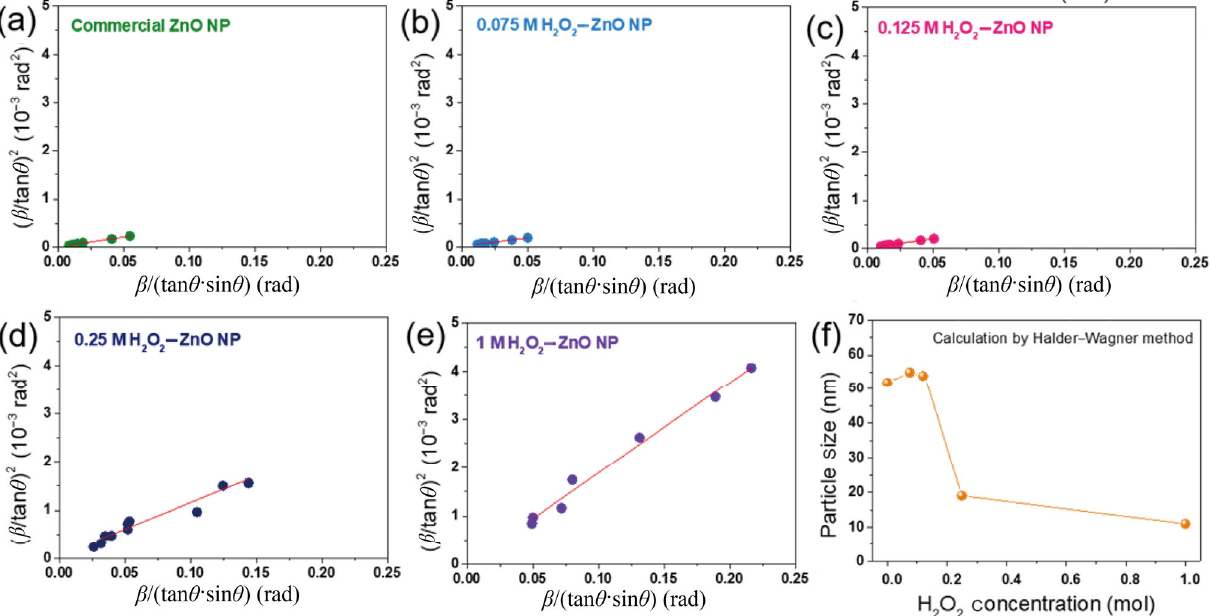
Fig. 3 Halder–Wagner plots of (a) commercial ZnO NPs, (b) 0.075 M H 2 O 2 treated/annealed ZnO NPs, (c) 0.125 M H 2 O 2 treated/annealed ZnO NPs, (d) 0.25 M H 2 O 2 treated/annealed ZnO NPs, and (e) 1 M H 2 O 2 treated/annealed ZnO NPs. (f) Crystalline size estimated from the slope of the linear